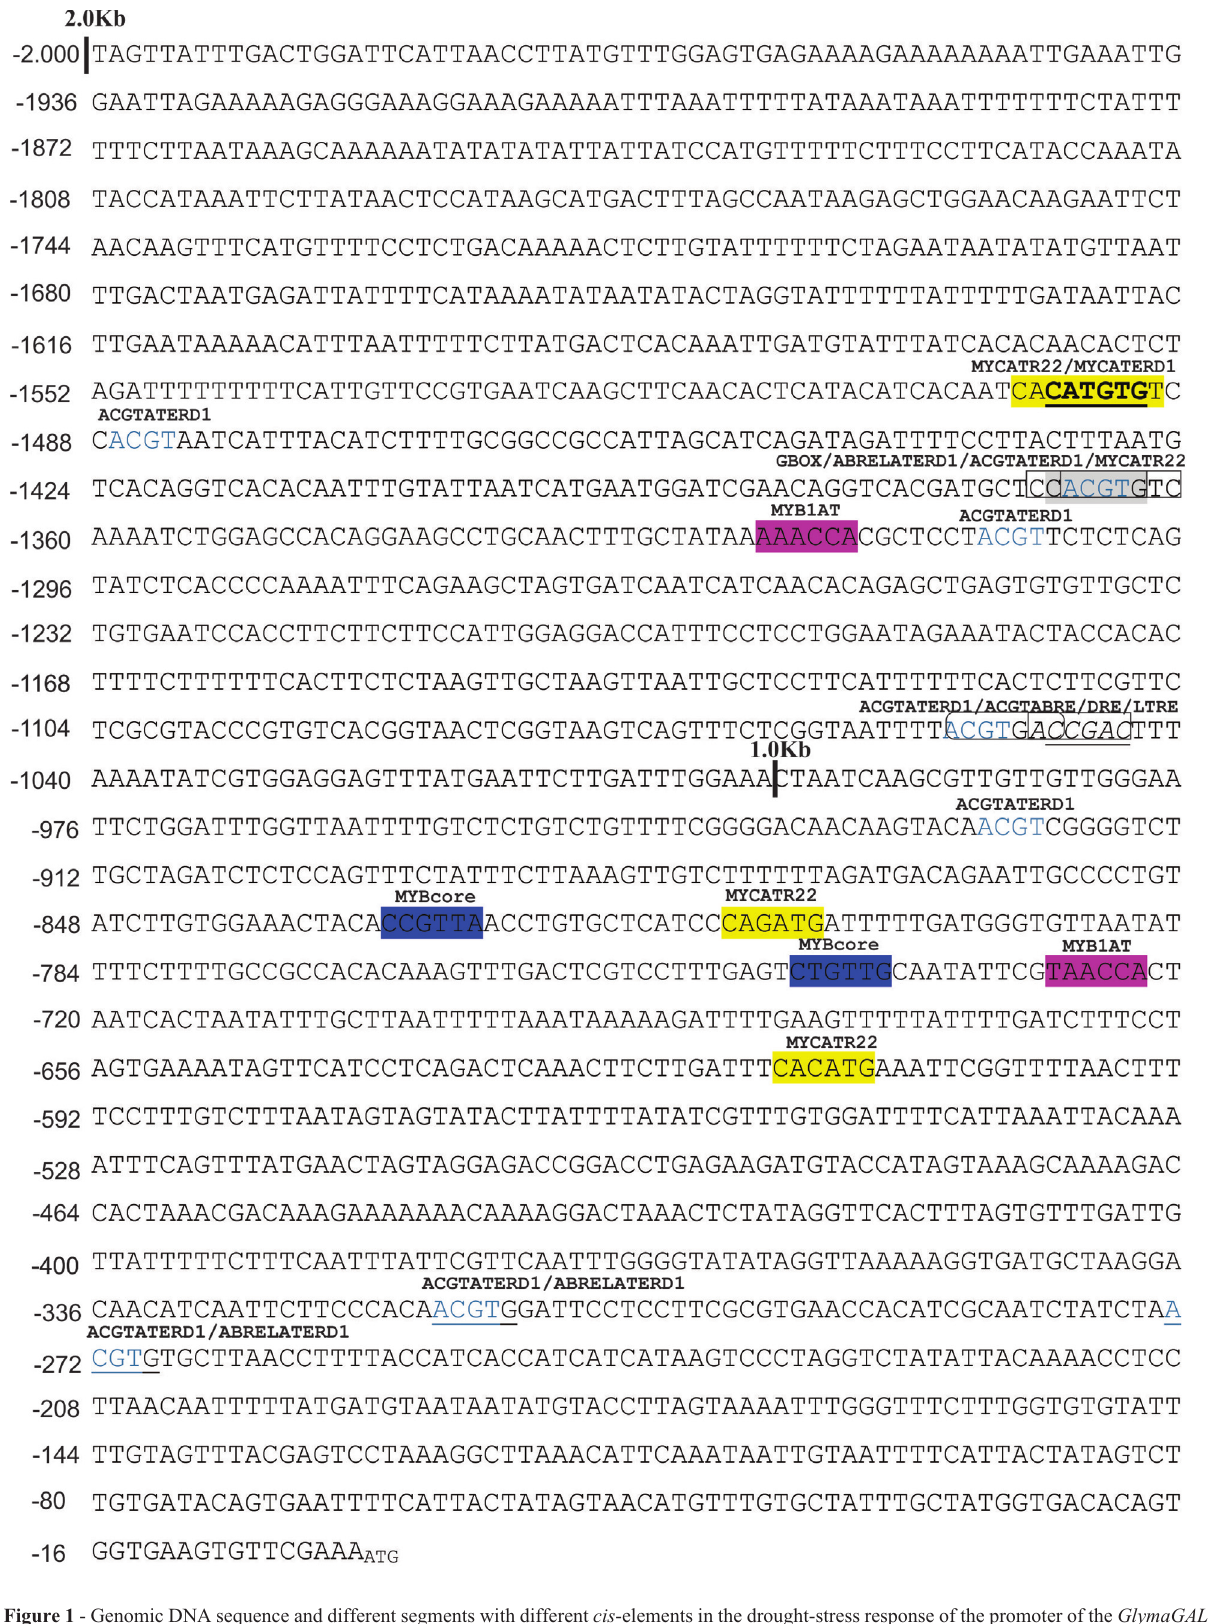
Figure 1 - Genomic DNA sequence and different segments with different cis -elements in the drought-stress response of the promoter of the GlymaGAL gene from soybean. The immediate upstream nucleotide of the start codon of GlymaGAL is designated as position 1. The sequence represents a sin- gle-stranded